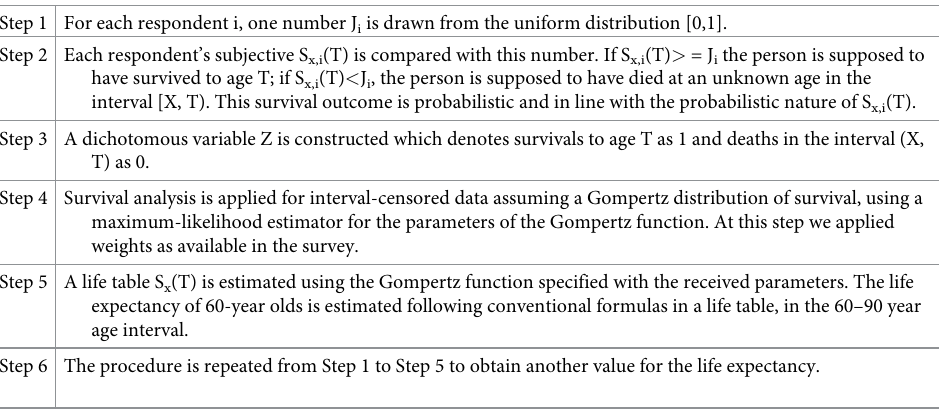
Table 2. Algorithm of the model applied for the estimation of subjective life